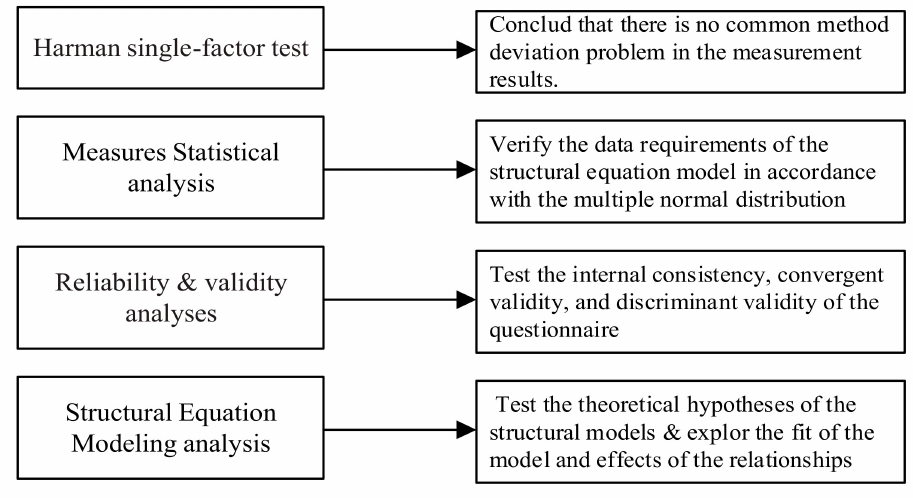
Figure 4. Four steps of data analysis.